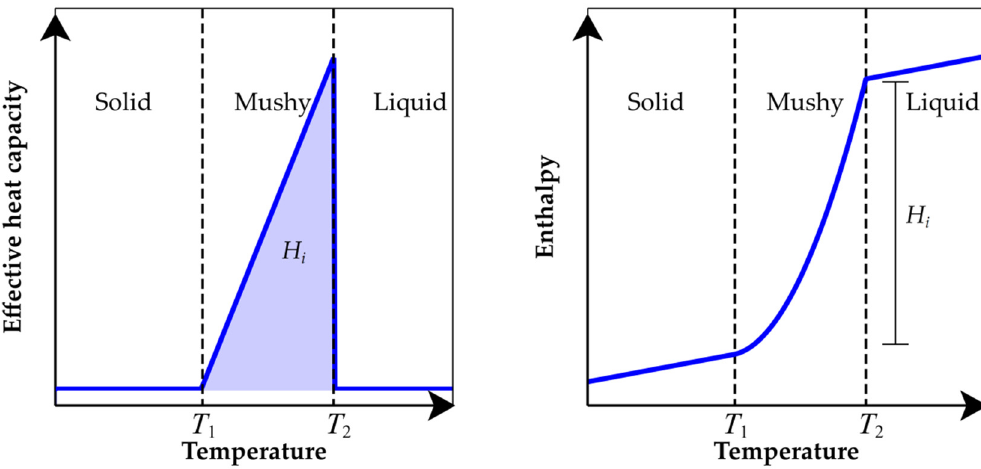
Figure 5. Relations between effective heat capacity and enthalpy.